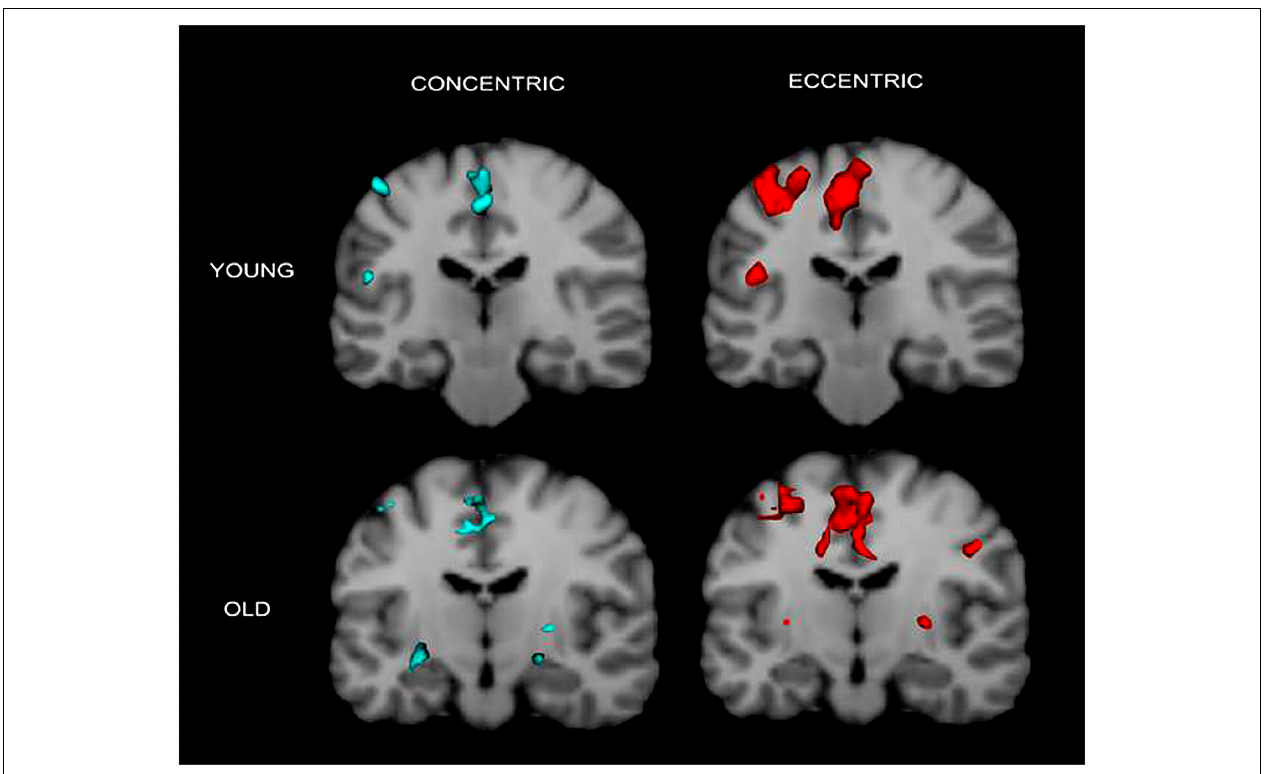
FIGURE 3 | Cronal view of group activation during the two types of contractions in the two groups. Again the figure shows that brain activation in young individuals are more localized in the contralateral (left) hemisphere